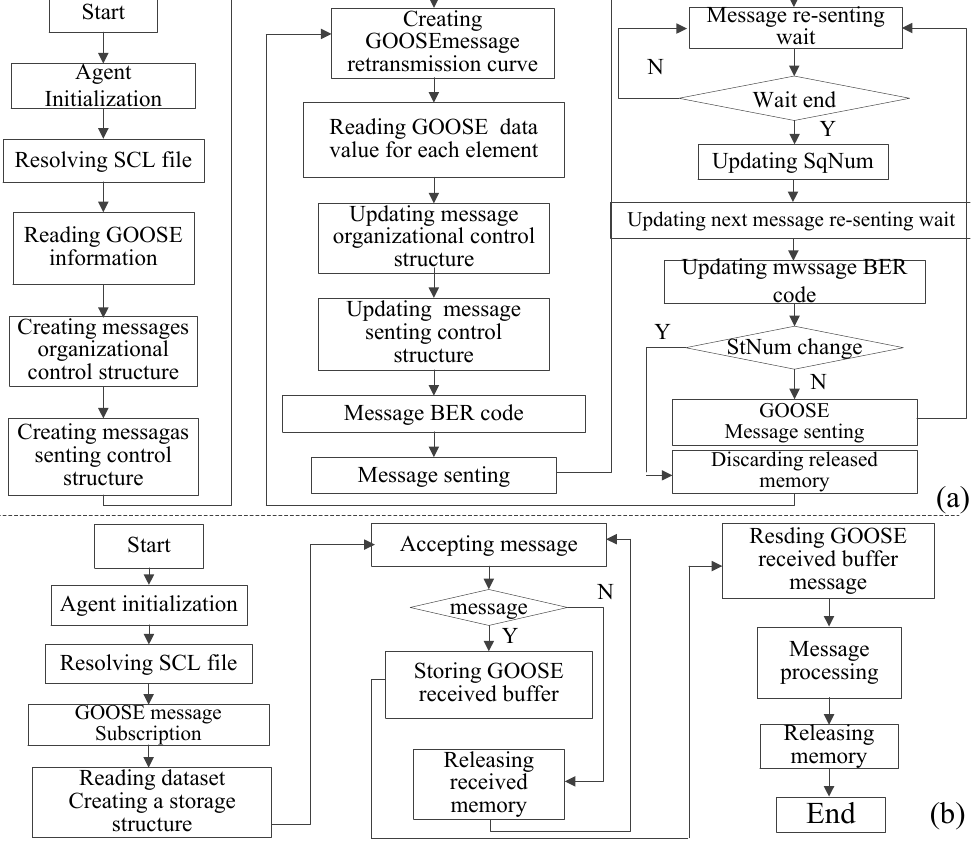
Figure A4. Workflow of ( a ) transmitting and ( b ) capturing GOOSE